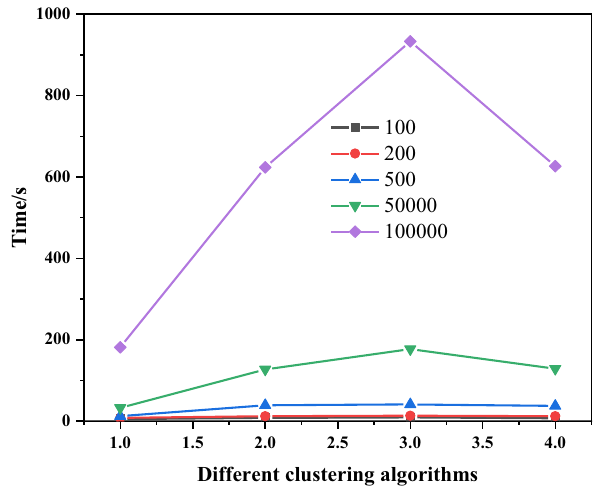
Figure 3: The computation time of each clustering algorithm with di ff erent sample